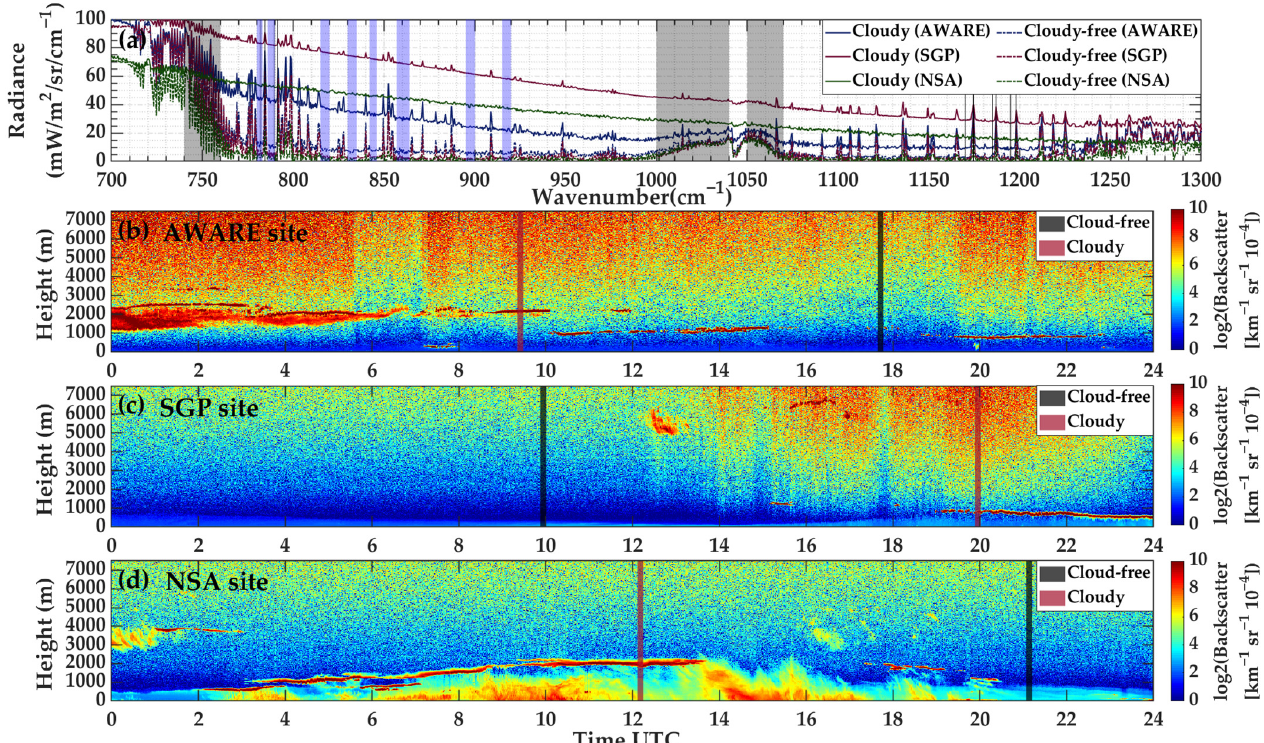
Figure 2. ( a ) Comparison of typical cloud-free and cloudy spectra in the three sites. The background parts in ( a ) represent the corresponding features in Table 3. ( b ) Echo map of ceilometer on 21 January 2016 of AWARE site. ( c ) Echo map of ceilometer on 3 February 2014 of SGP site. ( d ) Echo map of ceilometer on 13 January 2014 of NSA site. Table 3. Twelve selected features for distinguishing cloudy or cloud-free data. Features 1, 2, and 5– 12 correspond to the black background parts of Figure 2a, while features 3 and feature 4 correspond to the purple background parts.